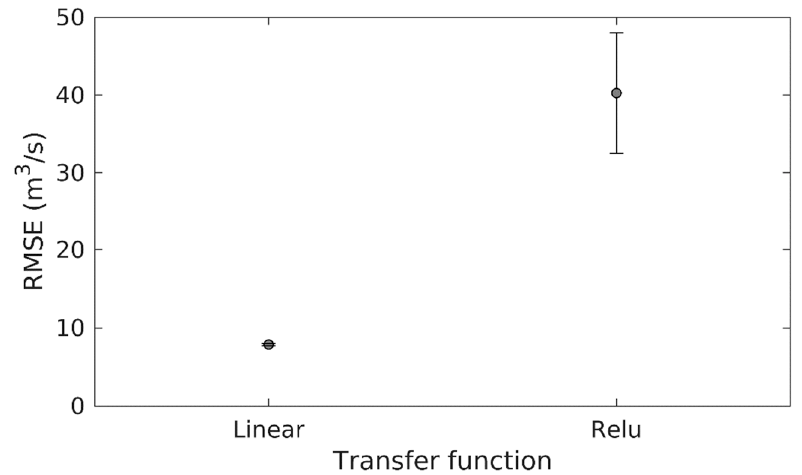
Figure 7. RMSE of a Maipo en el Manzano validation subset as a function of transfer function for the DL model.